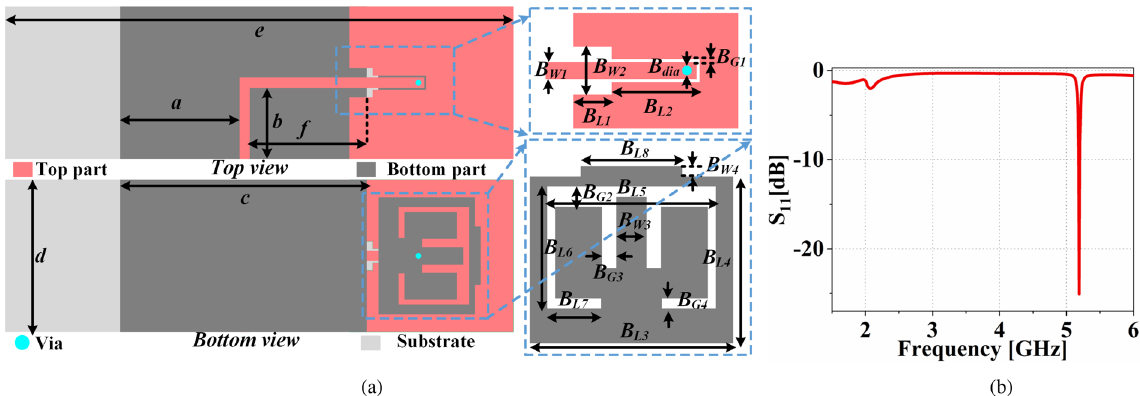
Figure 7. ( a ) Proposed antenna for sensing application. ( b ) Input reflection coefficient of the proposed antenna sensor.